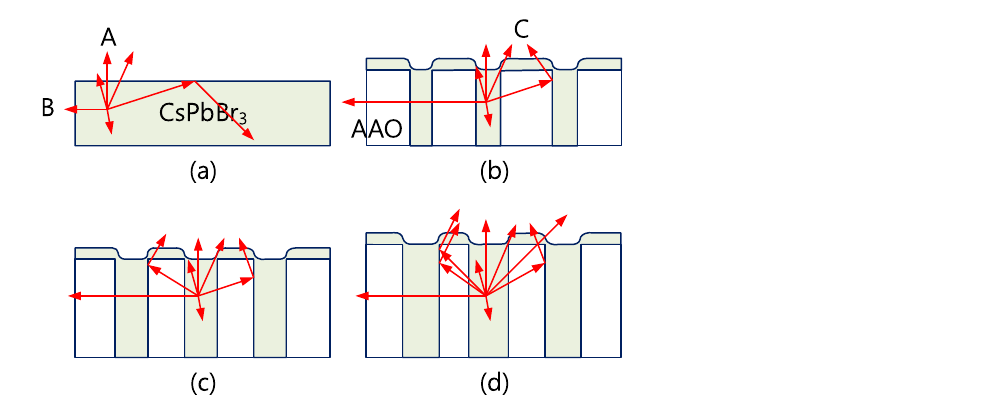
Figure 7. Emission diagram of the CsPbBr 3 active layer without and with the AAO structure using expanded pore treatment: ( a ) without the AAO structure, ( b ) with the AAO structure using 30 V treatment, ( c ) with the AAO structure using 40 V treatment, and ( d ) with the AAO structure using 50 V